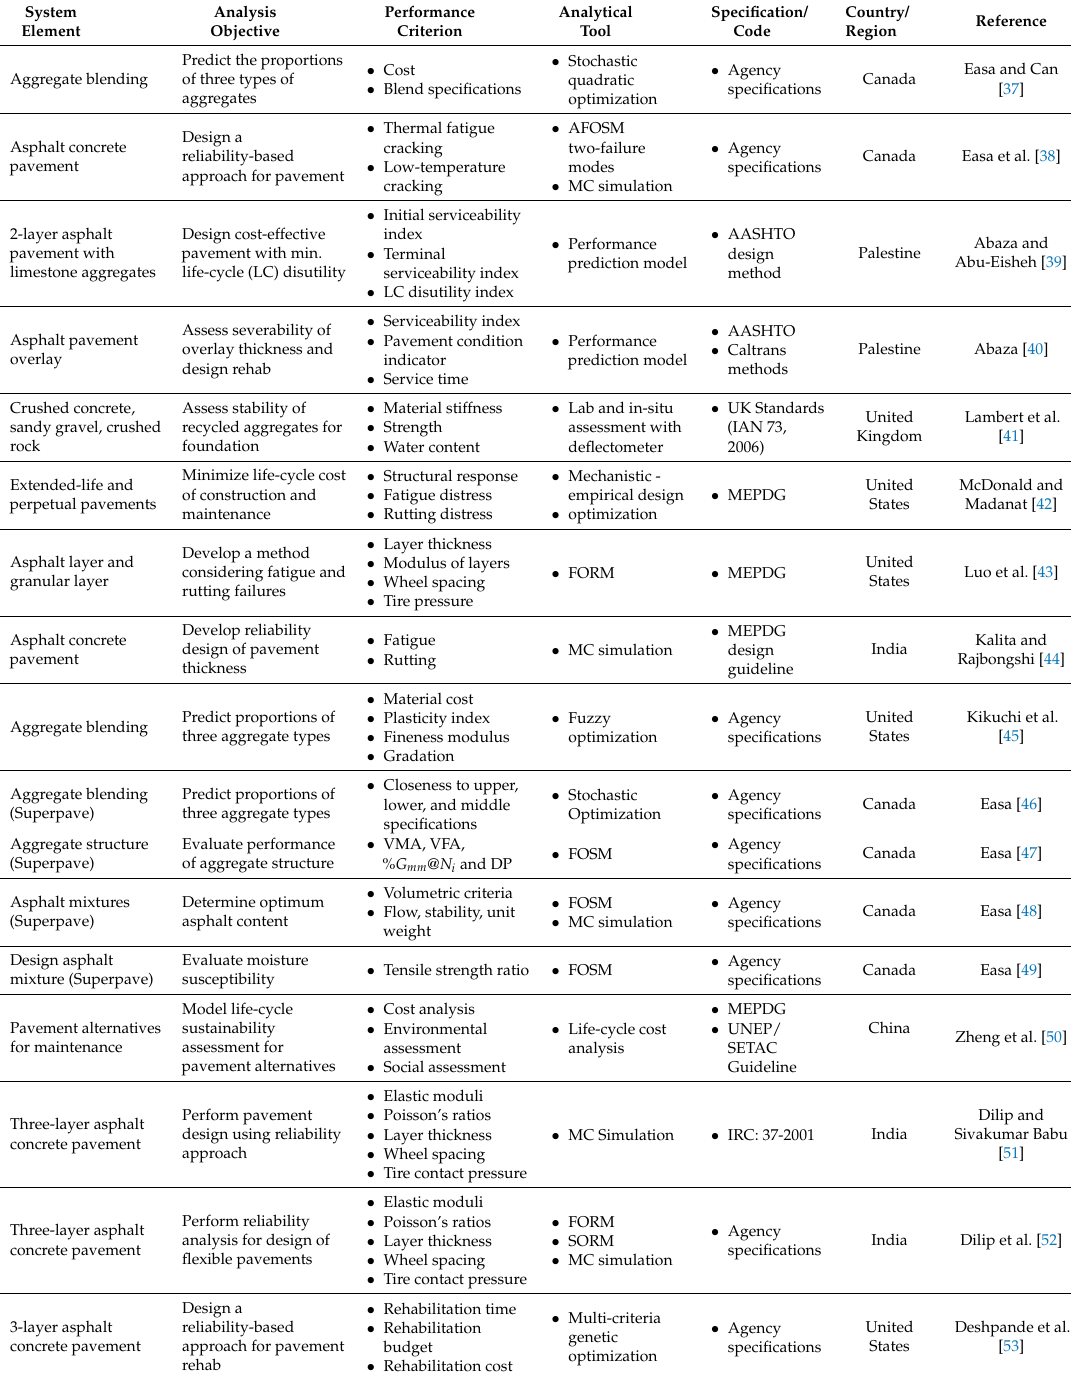
Table A2. Characteristics of pavement